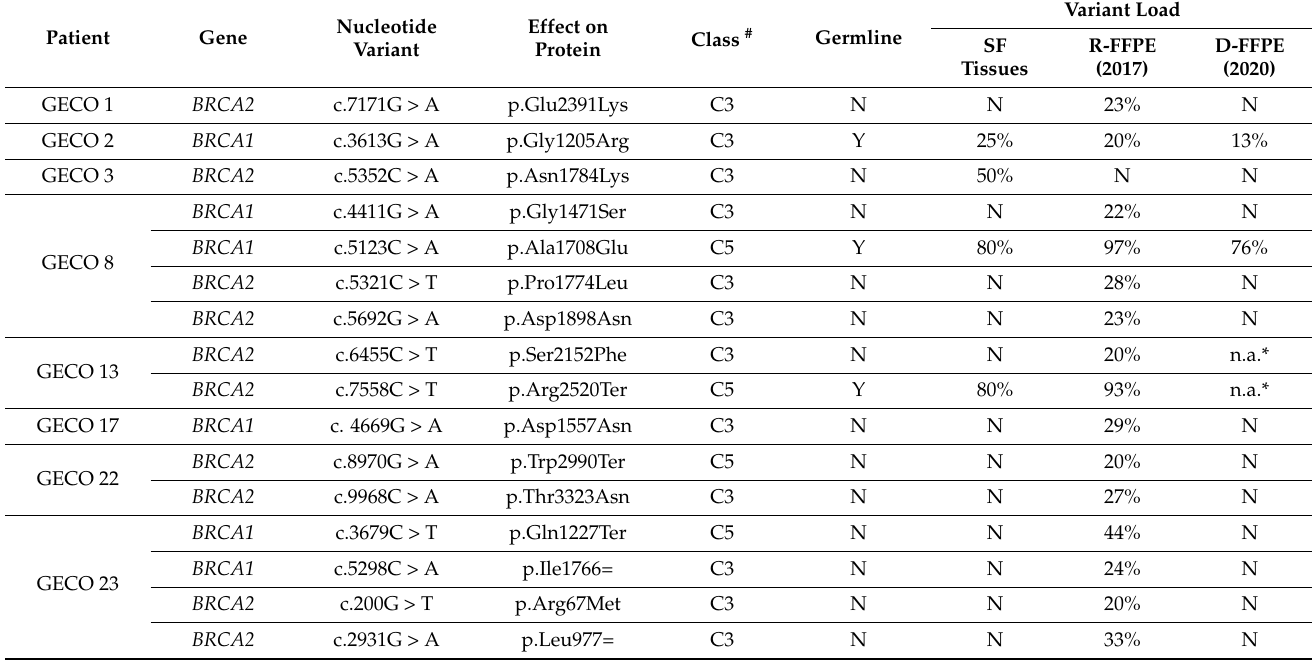
Table 3. Comparison between sequencing analysis results performed on different types of